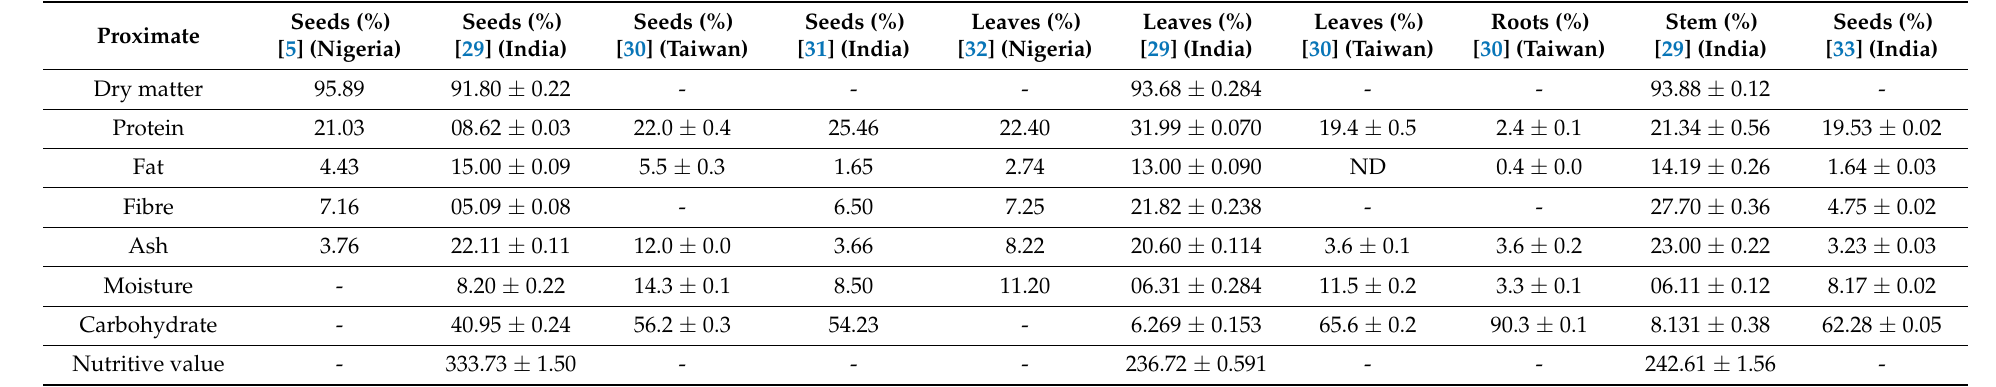
Table 2. Proximate composition of Cajanus cajan from different countries.